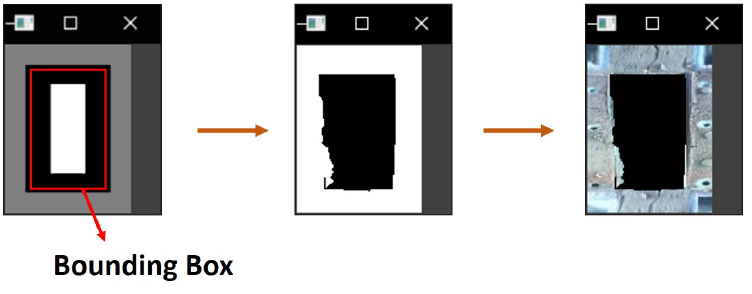
Figure 9. Labeling the foreground and background pixels automatically for the top